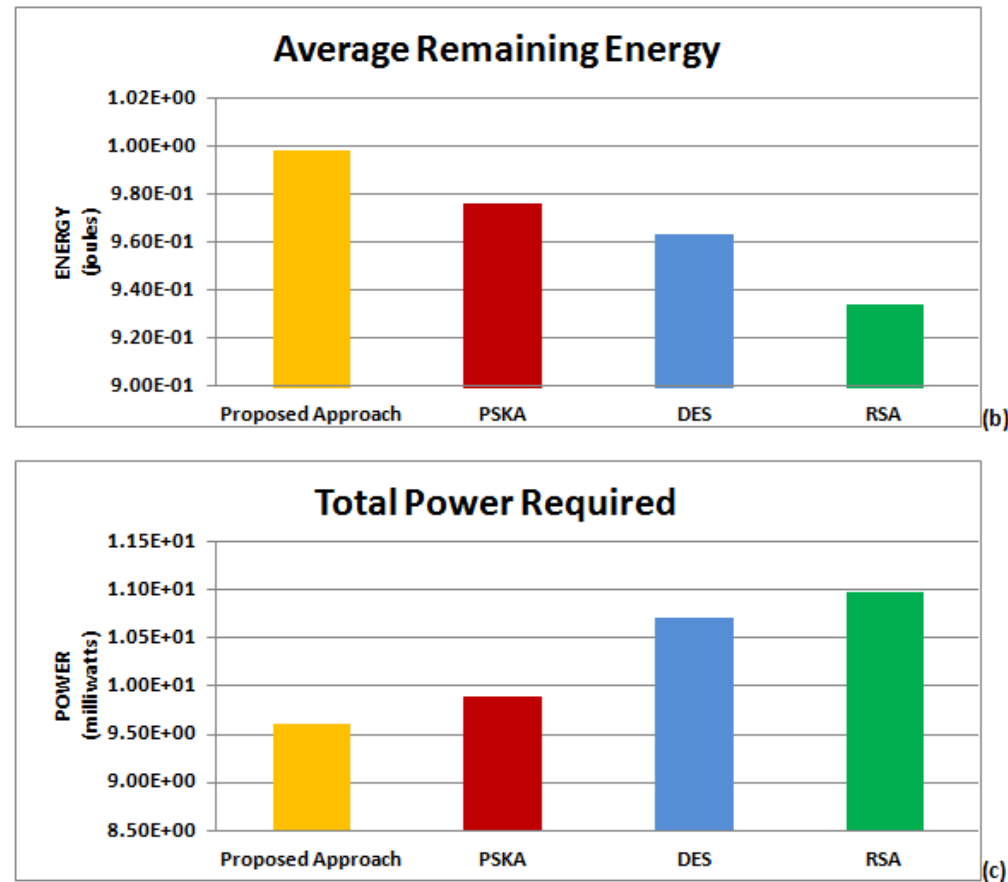
Figure 10. Performance analysis: ( a ) total Transmission Time for different methods; ( b ) average remaining energy for different methods; and ( c ) total power required for different